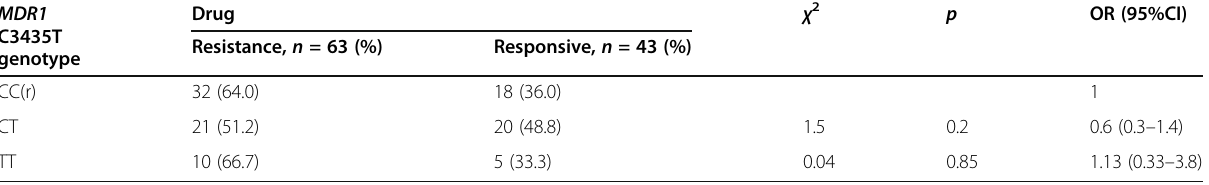
Table 1 Association between MDR1 C3435T SNP genotype and multidrug-resistant among epilepsy cases MDR1 C3435T